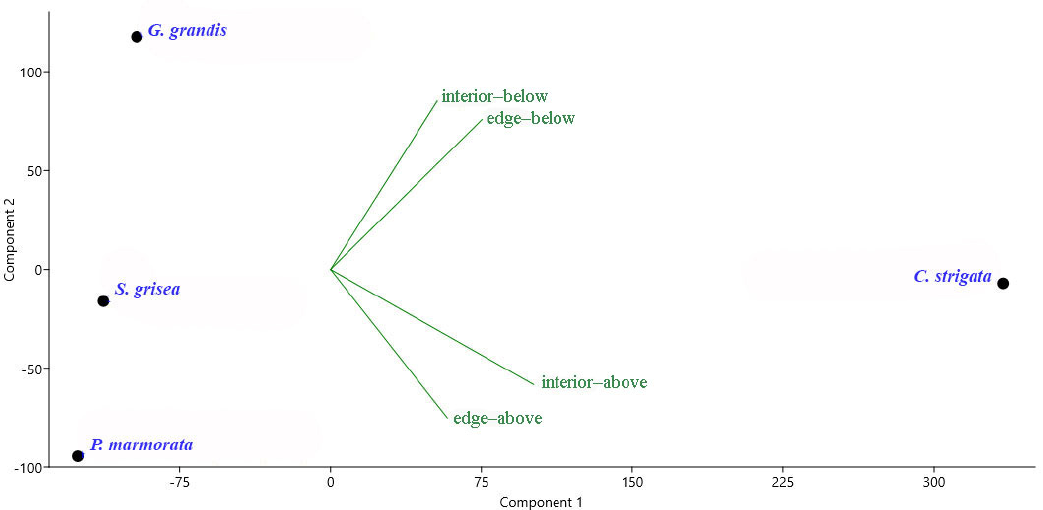
Figure 2. Principal component analysis (PCA) ordination diagram of some Coleoptera species based on their mean abundance at various heights of the bait trap positions (above—the height of 7.5 m, below—the height of 1.5 m) and the proximity of the forest edge (interior—inside the forest, edge—at the forest edge) in all four studied sites. Green represents bait trap positions, and purple represents four Coleoptera species. G. grandis — Glischrochilus grandis ; S. grisea — Soronia grisea ; P. marmorata — Protaetia marmorata ; C. strigata — Cryptarcha strigata .